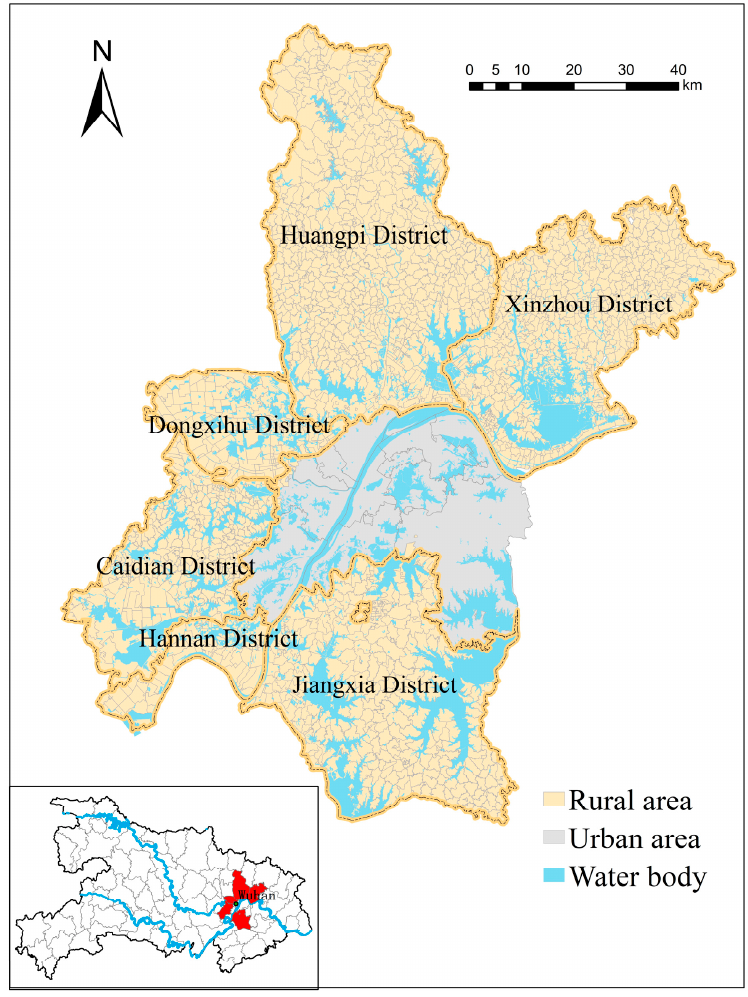
Figure 2. Location of the research area.